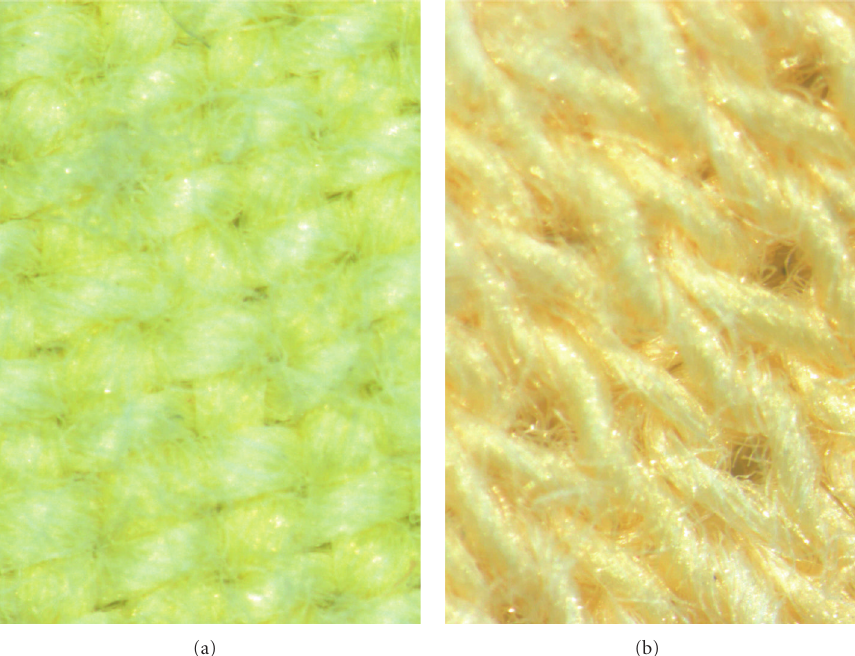
Figure 2: Fabrics (A) and (B), magnification is × 20. Fabric (A) has gauge 30 threads/cm in warp, 20 threads/cm in weft; Fabric (B) has 13stitches/cm and